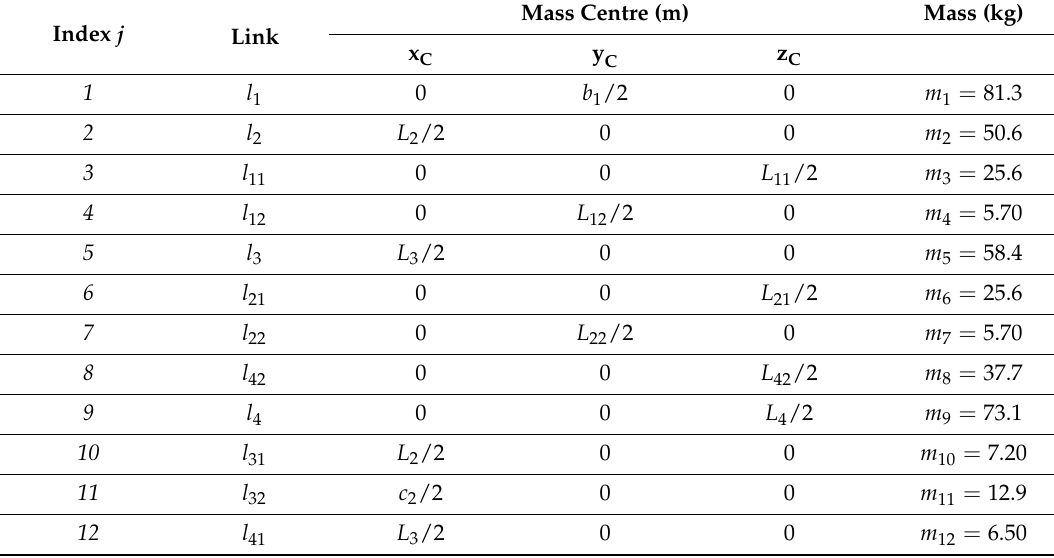
Table 2. Dynamic parameters of the